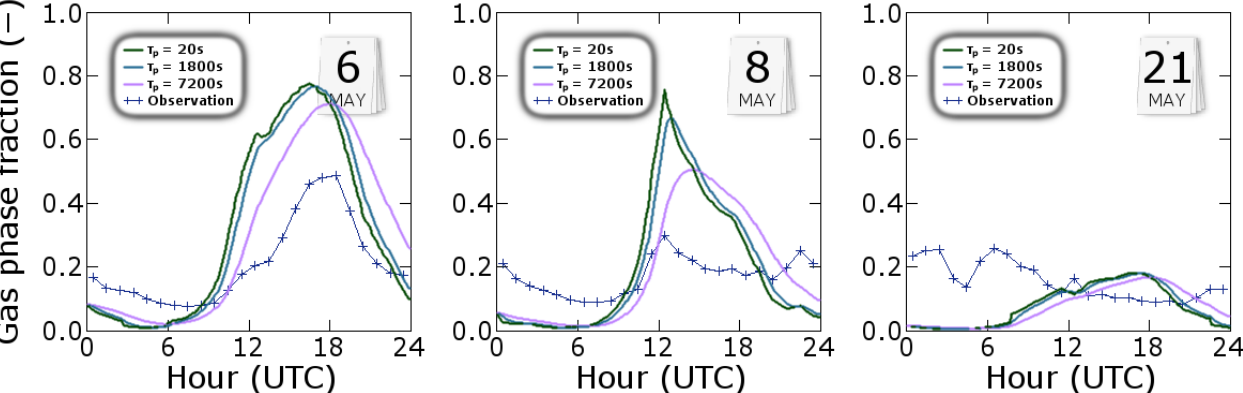
Fig. 4. Partitioning of nitrate, modelled by nudging the equilibrium calculated by ISORROPIA with different timescales, and observation, for 6, 8 and 21